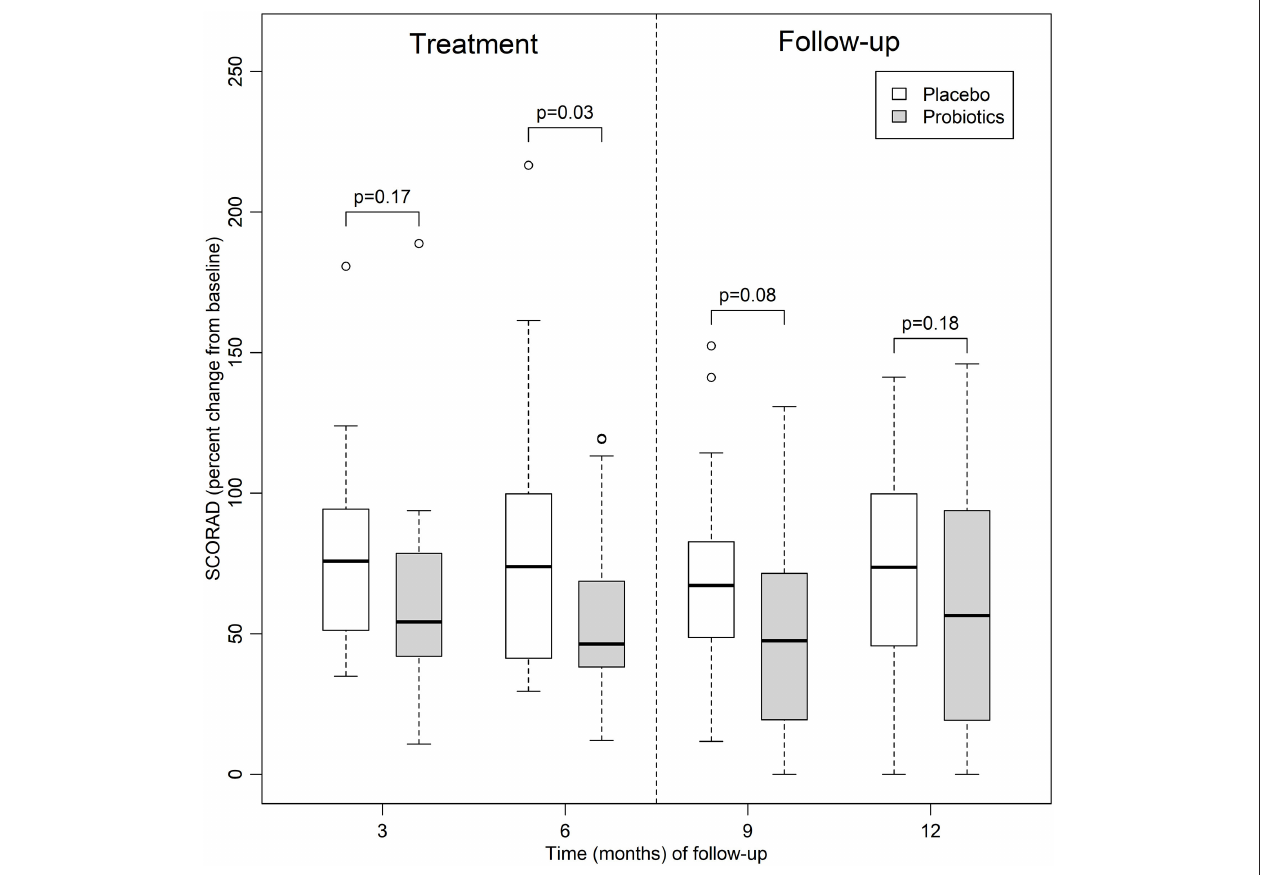
FIGURE 2 | Relative percent changes in SCORAD (from baseline) in the probiotics and placebo groups up to 12 months of